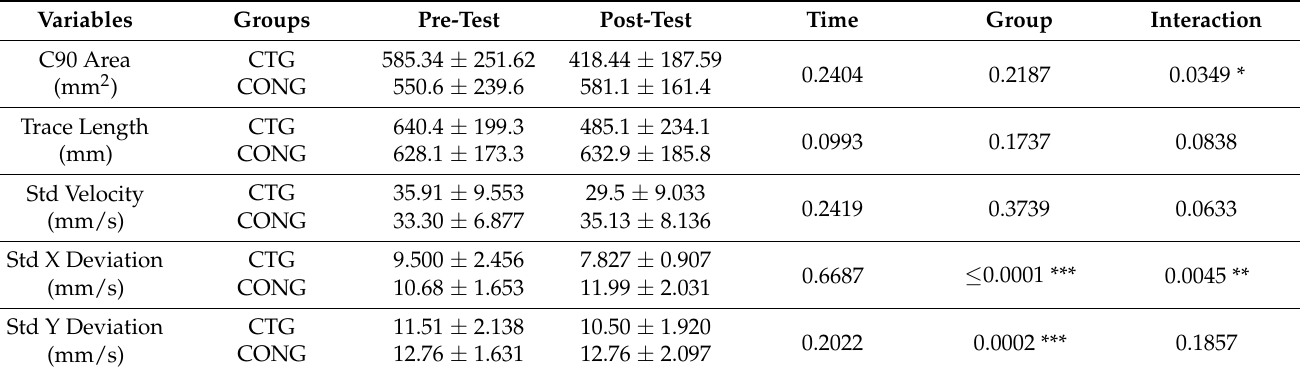
Table 5. Comparative analysis of various indicators of static balance before and after the experiment with eyes open and feet standing